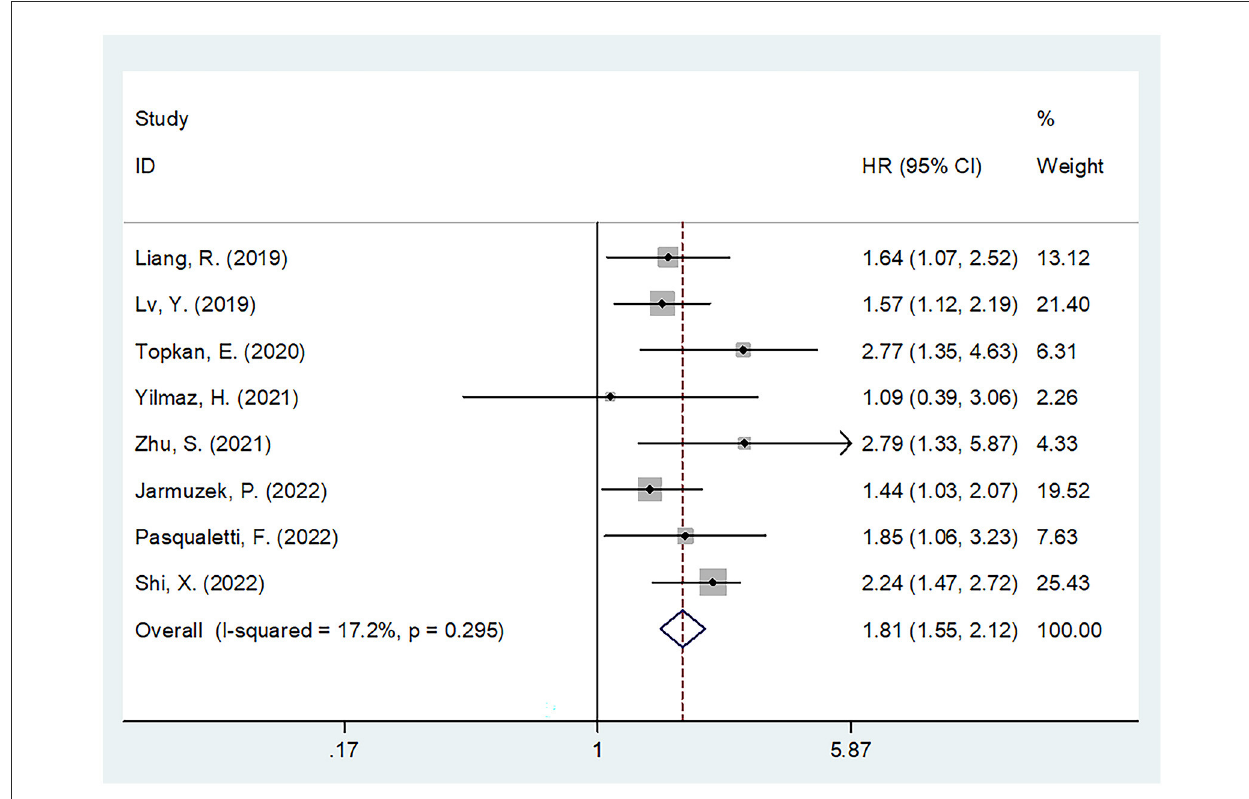
FIGURE2 Forest plot of the association between SII and overall survival of glioma.